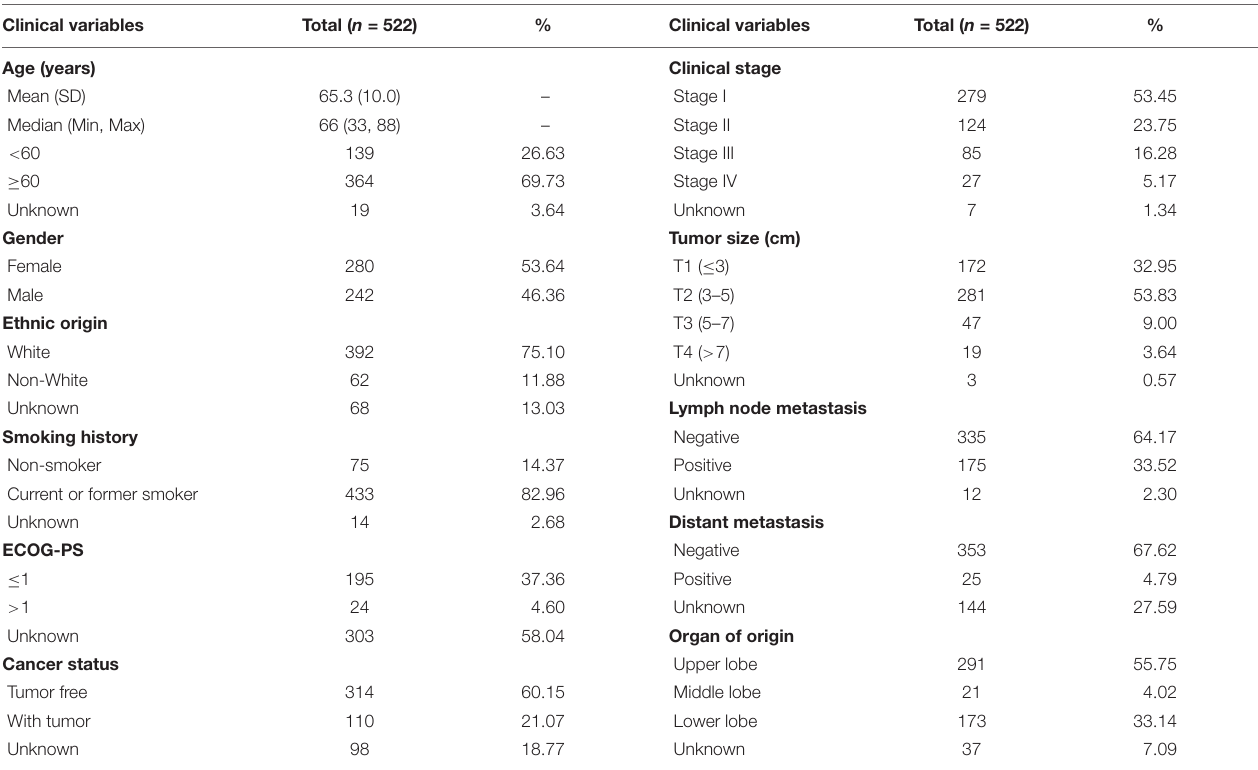
TABLE 1 | The clinical characteristics of LUAD patients from TCGA. Clinical